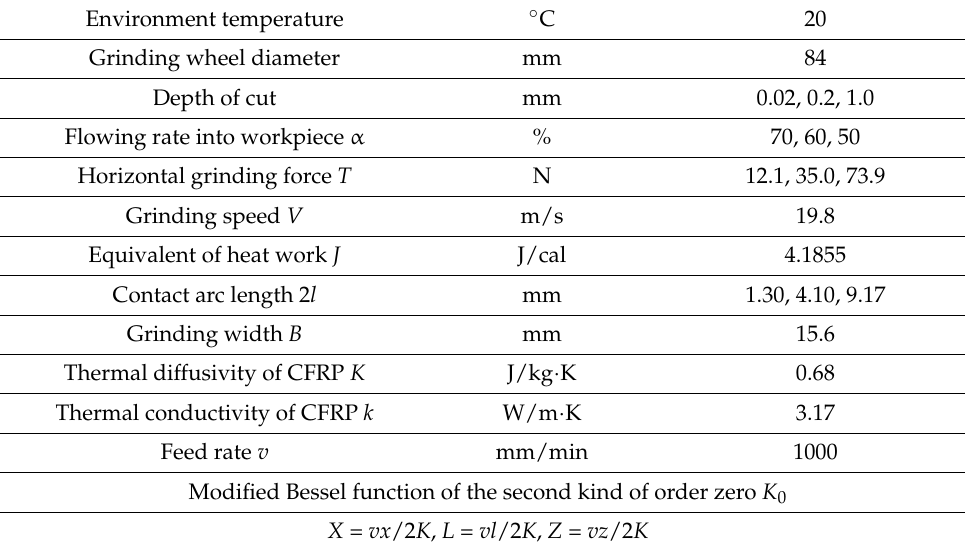
Figure 13. Heat source moving model for temperature analysis. Table 6. Analysis parameters.